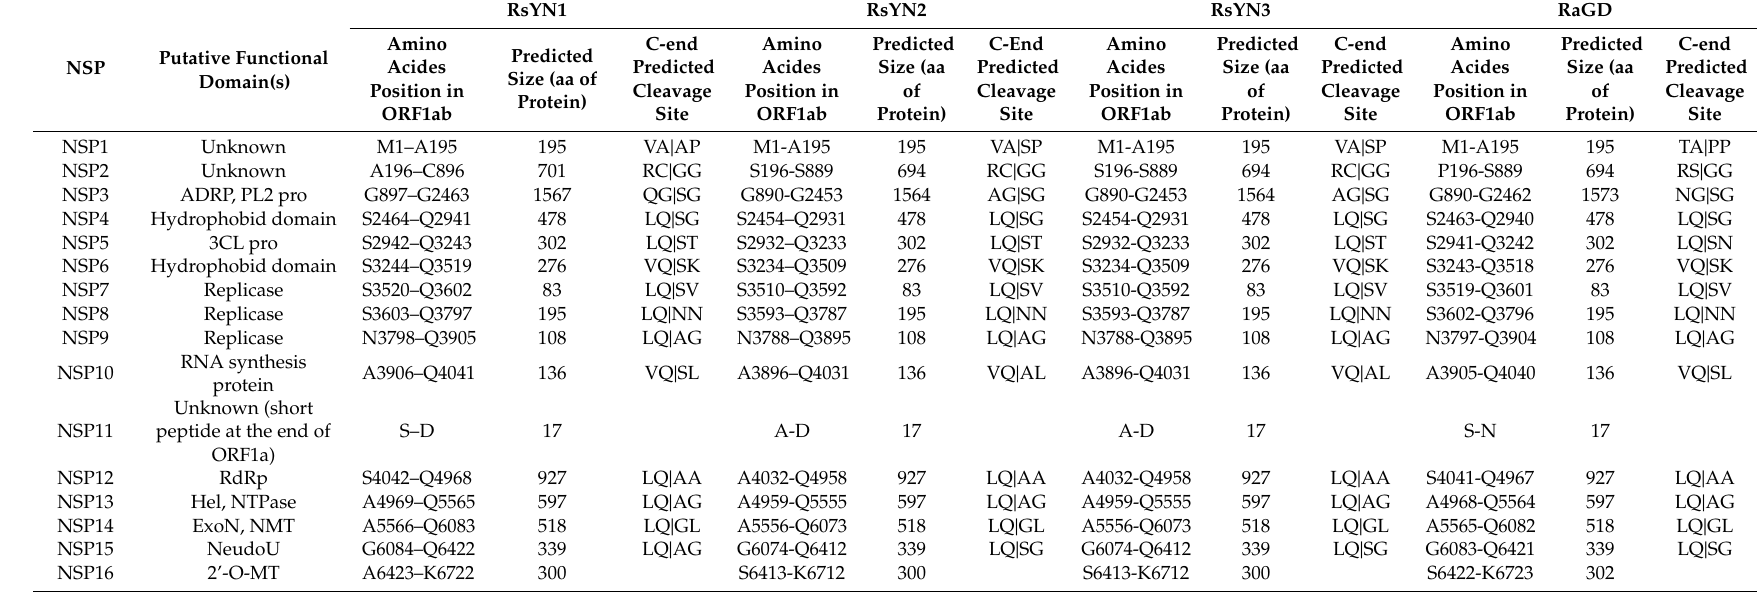
Table 3. Characteristics of predicted nonstructural proteins of ORF1ab in di ff erent stains of BtCoV / Rh /